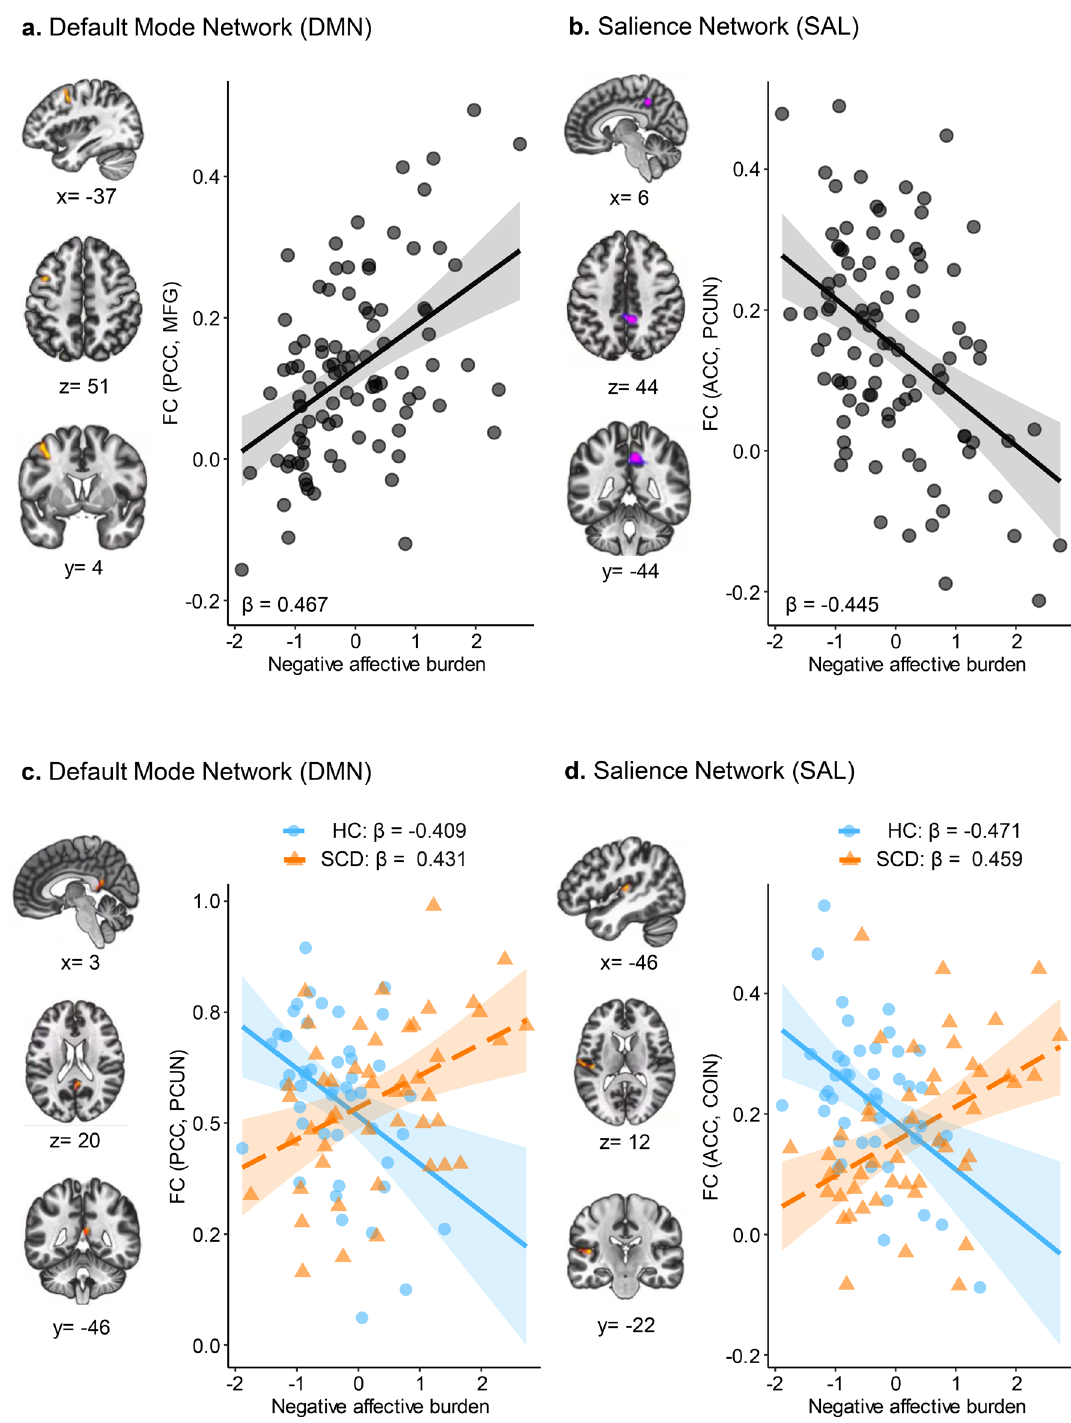
Figure 1. Effect of negative affective burden on functional connectivity. ( a , b ) Main effects of the negative affective burden composite on functional connectivity. For the Default Mode Network ( a , PCC seed), greater negative affective burden was associated with higher coupling between the PCC and the left middle frontal gyrus (MFG). For the Salience Network ( b , ACC seed), greater negative affective burden was associated with lower functional connectivity between the ACC and the precuneus (PCUN). ( c , d ) Interactions between the negative affective burden composite and subjective cognitive decline (SCD) group status on functional connectivity. Greater negative affective burden was associated with higher regional functional connectivity in the SCD group and with lower regional functional connectivity in the healthy control (HC) group. For the Default Mode Network ( c , PCC seed), brain regions included the cingulate gyrus/PCUN and for the Salience Network ( d , ACC seed) the left central opercular/insular cortex (COIN). ( a – d ) Maps were displayed with a voxel-level threshold of p < 0.005 and a cluster-level threshold of p < 0.05 FDR-corrected. Individual relationships were illustrated using scatterplots with fitted regression, shaded areas indicate 95% confidence intervals and dots represent individual functional connectivity values extracted from significant clusters of the voxel-wise regression analyses. Standardized beta values (β) are presented for main ( a , b ) and interaction effects ( c , d ). ACC anterior cingulate cortex, FC functional connectivity, FDR false discovery rate, HC healthy controls, PCC posterior cingulate cortex, SCD subjective cognitive